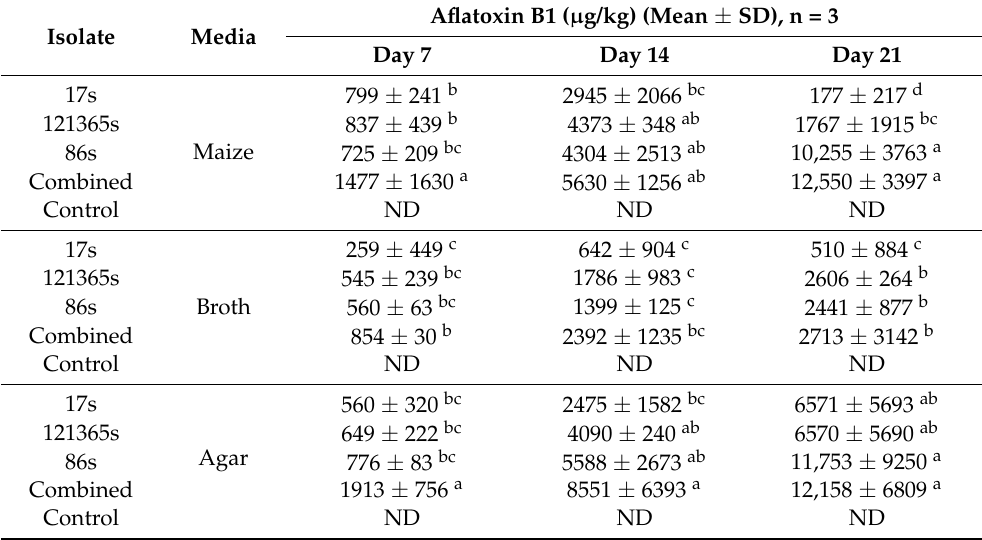
Table 1. Aflatoxin B1 production in the three media inoculated with various A. flavus strains.